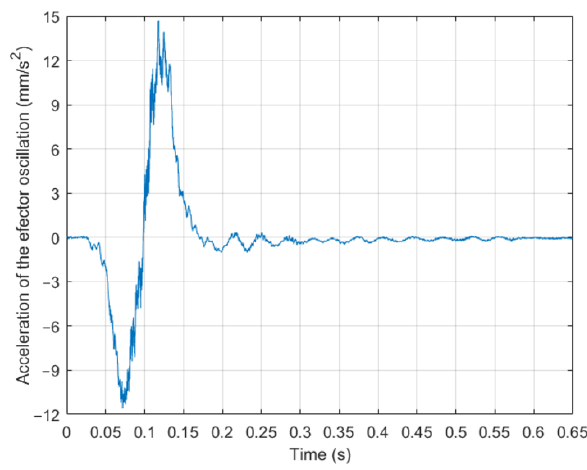
Figure 3. The stabilization process of the robot effector, recorded after a stop at the target point.